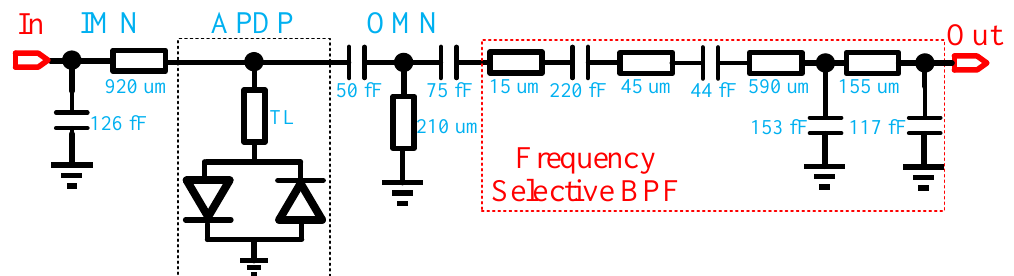
Figure 2. Schematic of the frequency tripler and its cascaded frequency selective BPF.